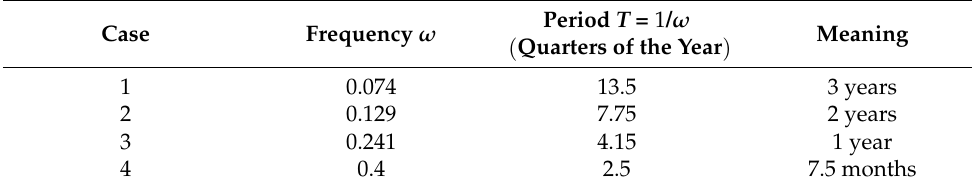
Table 3. Frequency choice for visualisation of the time series.